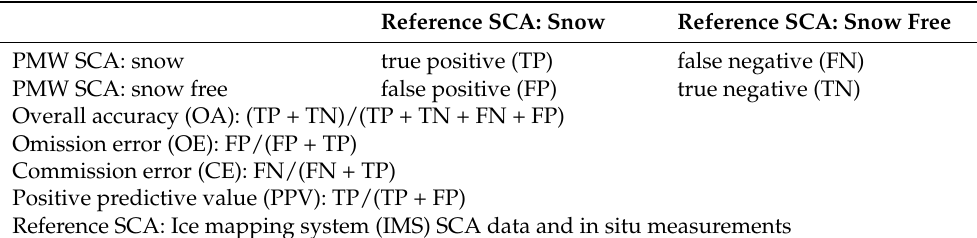
Table 2. Classification error